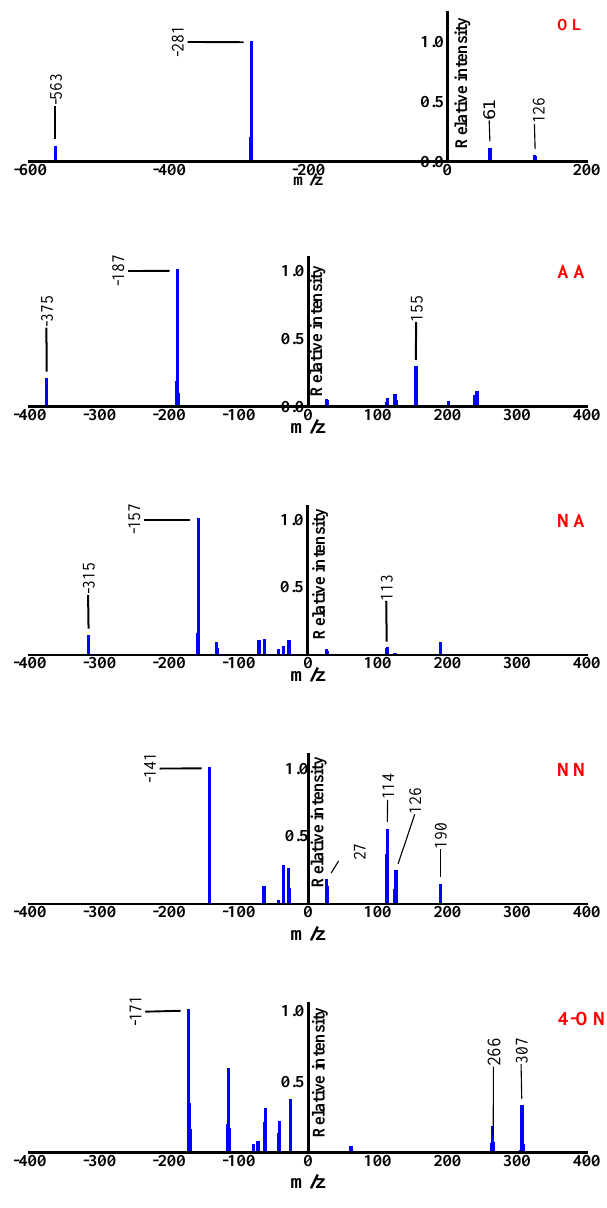
Figure 3. Positive and negative ion mass spectra of OL, AA, NA, NN, and 4-ON. Each spectrum presented represents the average from 100 mass